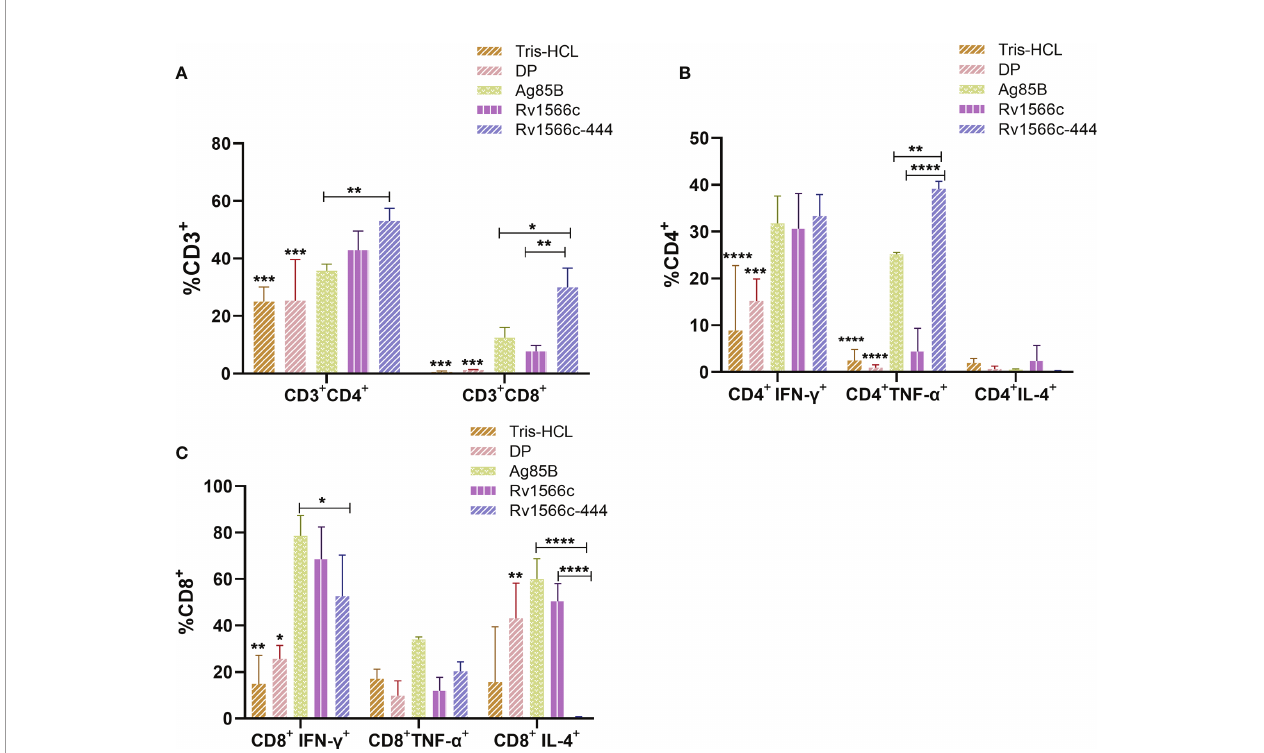
FIGURE 6 | Proportions of CD3 + CD4 + T cells and CD3 + CD8 + T cells in spleen cells from mice immunized with different vaccines and proportions of CD4 + or CD8 + T cells that secreted different cytokines. Splenocytes from BALB/c mice immunized with protein vaccines were respectively stimulated with the protein used in each vaccine, DP adjuvants, and Tris-HCl were stimulated with Rv1566c-444. The proportions of cells were assessed by fl ow cytometry. (A) Proportions of CD3 + CD4 + T cells and CD3 + CD8 + T cells in spleen cells from mice immunized with different vaccines. (B) Proportion of CD4 + T cells producing IFN- g /TNF- a /IL-4. (C) Proportion of CD8 + T cells producing IFN- g /TNF- a /IL-4. The signi fi cant differences between the Rv1566c-444 group and negative controls (DP and Tris-HCl groups) both stimulated with Rv1566c-444 are represented by asterisks above the bar; signi fi cant differences among antigens groups were presented by capped lines with asterisks. The statistical signi fi cance was determined using one-way ANOVA with Turkey ’ s multiple comparison tests (* P < 0.05, ** P < 0.01, *** P < 0.001, **** P <